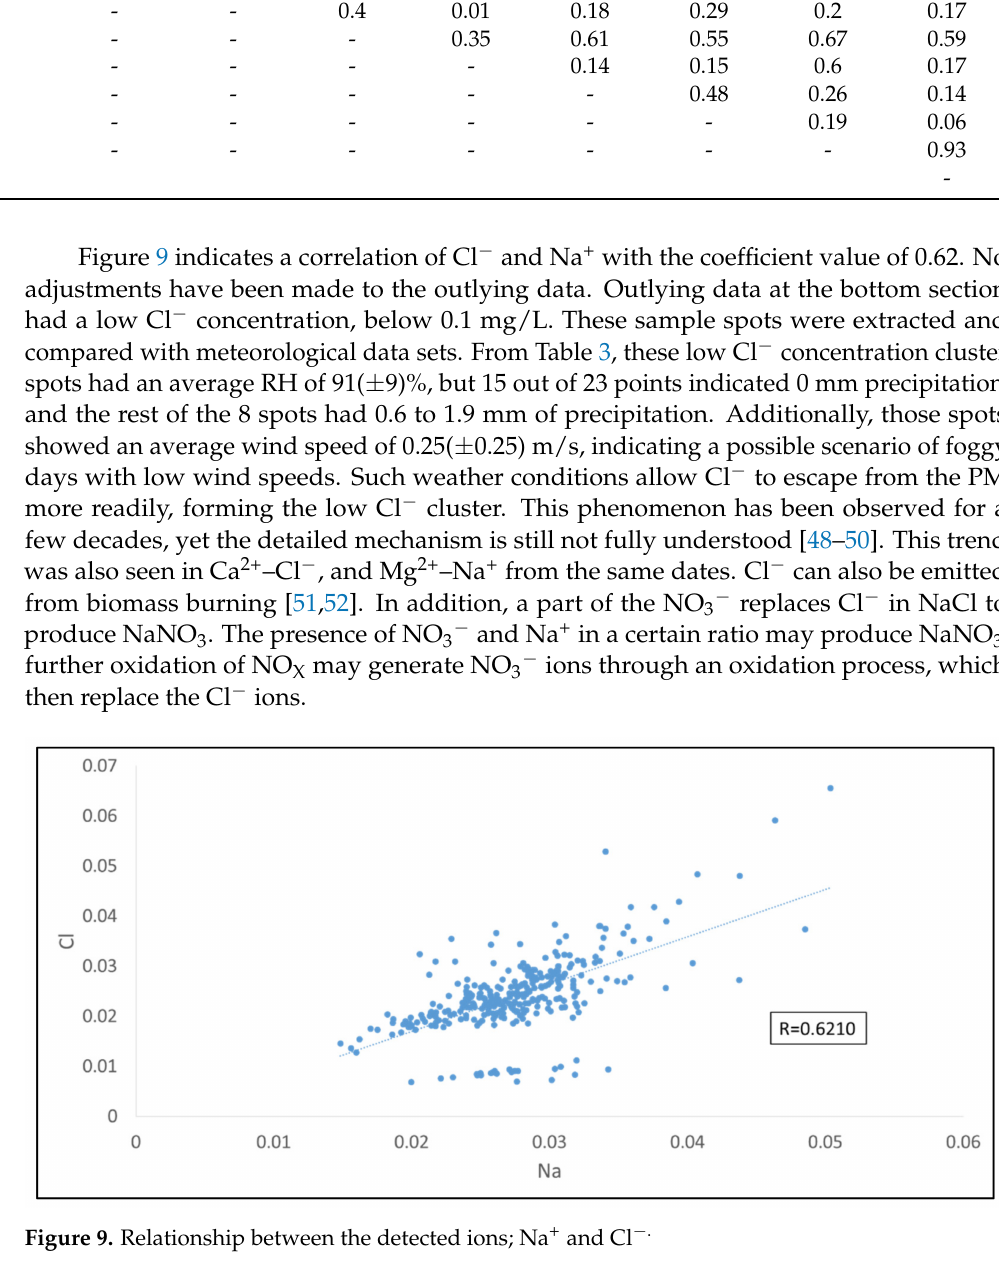
Table 2. The correlation matrix between ions and PM 2.5 . The bold font indicates the highest correlation coefficient value.